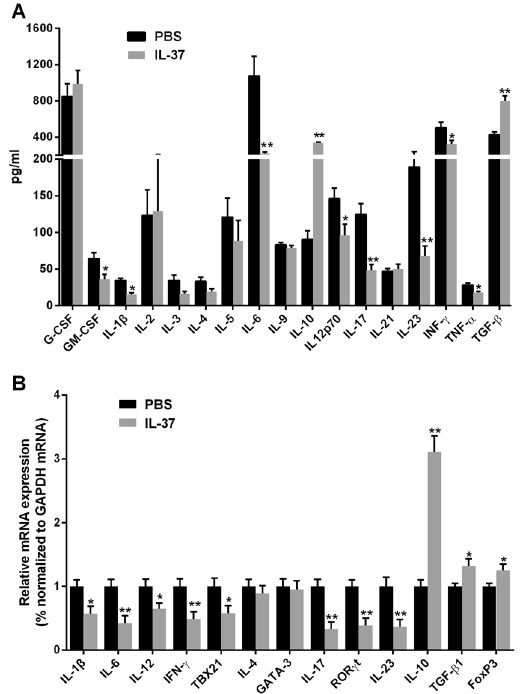
Figure 6. The levels of plasma cytokines in the two groups and the mRNA expression in the aorta. ( A ) The levels of plasma G-CSF, GM-CSF, IL-1 β , IL-2, IL-3, IL-4, IL-5, IL-6, IL-9, IL-10, IL-12p70, IL-17, IL-21,IL-23, IFN- γ , TNF- α and TGF- β 1 in the two groups. ( B ) Expression of IL-1 β , IL-4, IL-6, IL-10, IL-12p70, IFN- γ , TBX21, ROR γ T, IL-17, IL-23, GATA-3, TGF- β 1 and FOXP3 mRNA in aorta in the two groups. Values are presented as the means ± SEM, n = 5 to 7. * p < 0.05, and ** p <